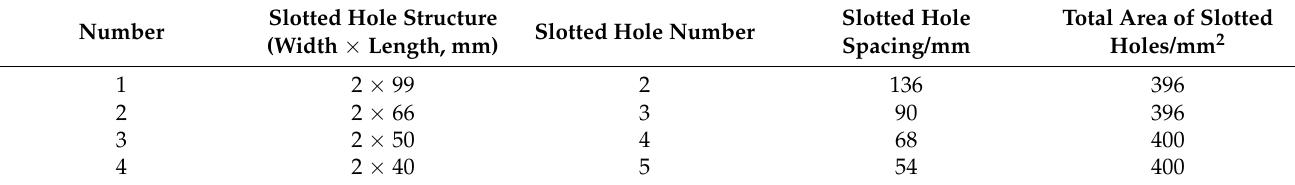
Table 1. Parameters of the slotted blowing hole.